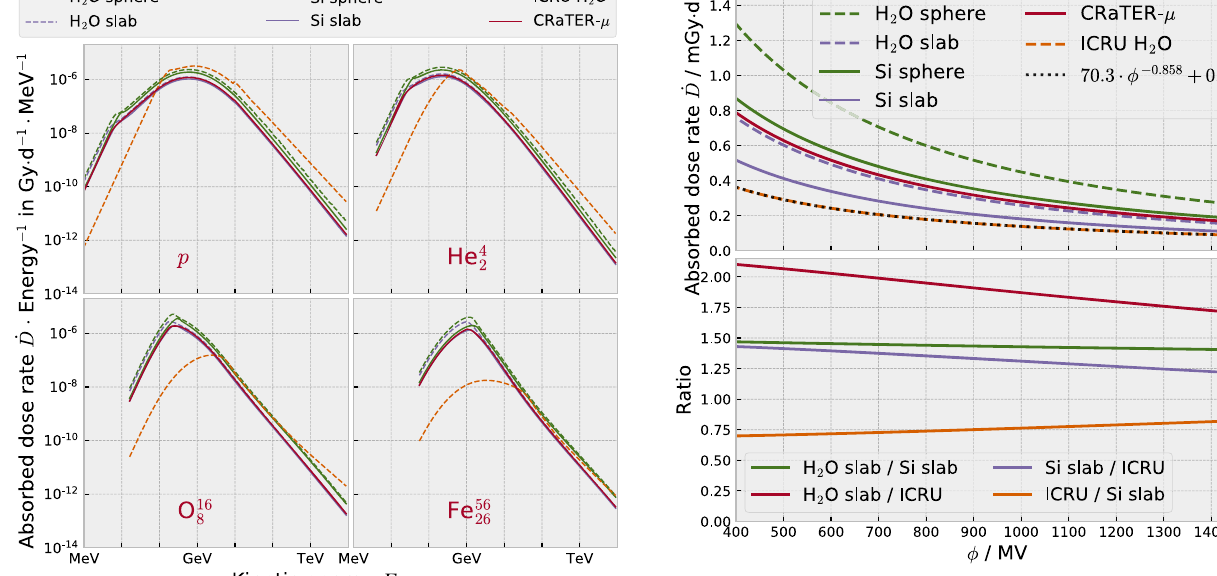
Fig. 5. Absorbed dose rate seen by the different detectors as a function of the solar modulation parameter has been obtained by calculating the absorbed dose rate using equation (6) for a series of / values covering the range between 400 MV and 1500 MV using 10 MV steps. All thin detectors overestimate the absorbed dose rate to the ICRU phantom (orange dashed line). These results indicate that measuring the absorbed dose rate using thin semiconductor detectors would result in an overestimation of the absorbed dose rate relative to the ICRU sphereradiological hazard to humans and that this overestimation increases as the detector thickness is reduced (CRaTER- l ). The dotted black line in the upper panel, overlapping the ICRU plot, represents the best fi t in the least-squares